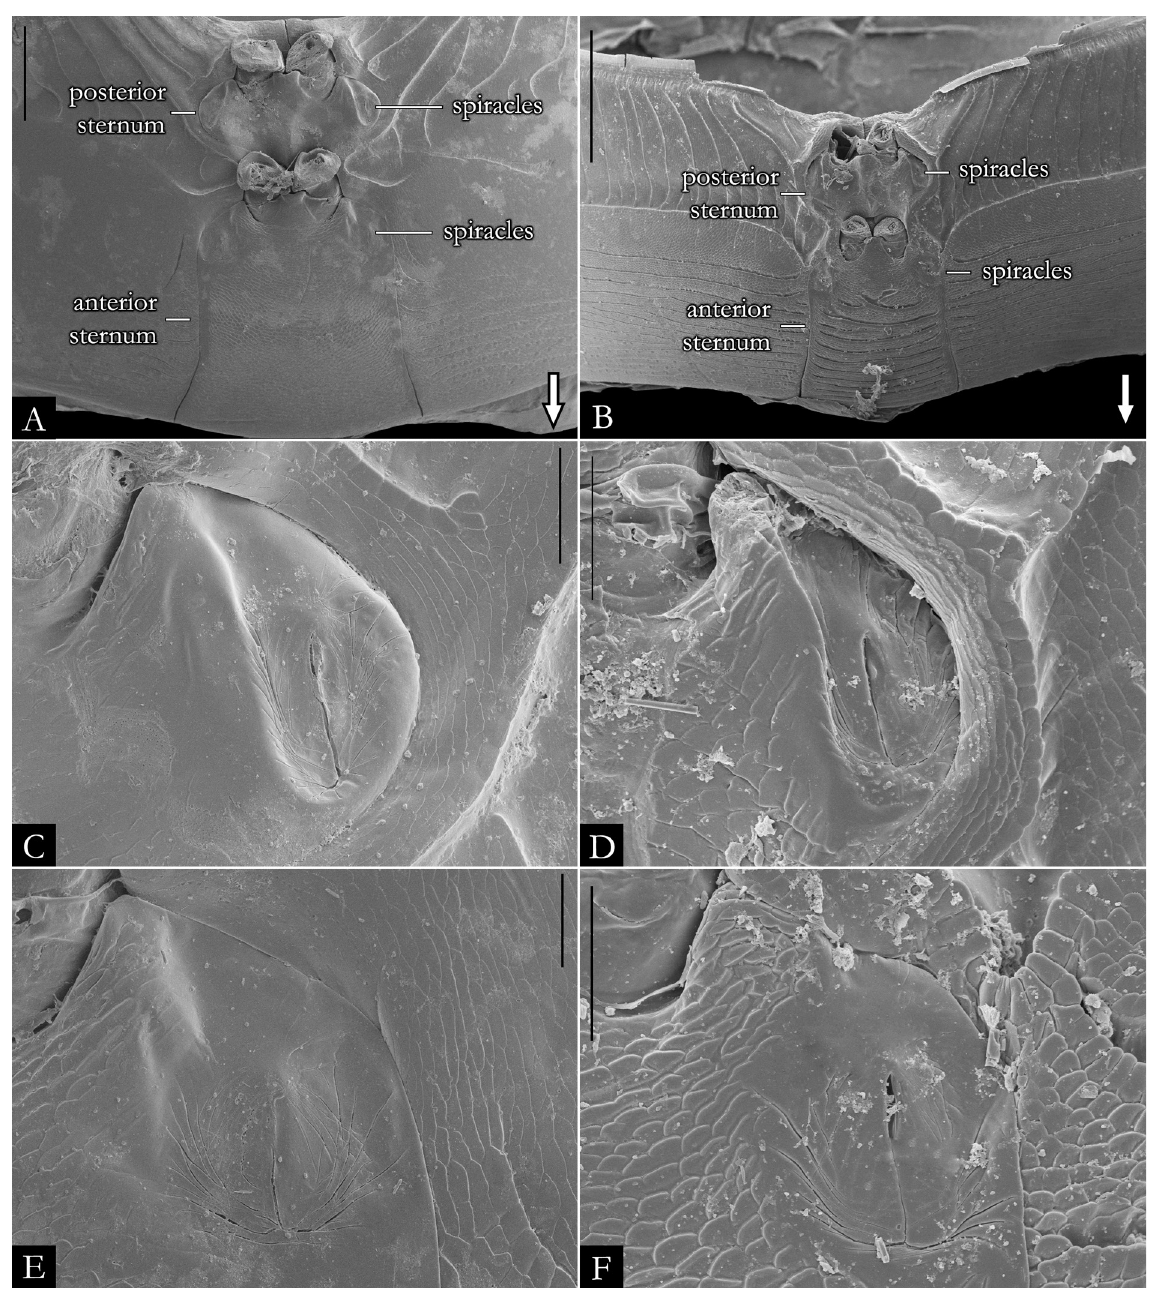
Fig. 25. SEM images of sternum. A . Pseudonannolene paulista Brölemann, 1902 (IBSP 1908). B . P. caatinga Iniesta & Ferreira, 2014 (IBSP 2180). C . Spiracle on the posterior sternum of P. paulista (IBSP 1908). D . Spiracle on the posterior sternum of P. caatinga (IBSP 2180). E . Spiracle on the anterior sternum of P. paulista (IBSP 1908). F . Spiracle on the anterior sternum of P. caatinga (IBSP 2180). Scale bars: A = 0.25 mm; B = 0.5 mm; C, E = 0.05 mm; D = 0.1 mm; F = 0.2